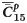
Average outflow facility C¯15p, as a function of intraocular pressure and for a range of values of α.The average outflow facility
C¯15p
is calculated using Eq (28). Note: the average outflow facility curves shown in the figure above are not the same as the average outflow facility curves shown in Fig 2, as the pressure range over which averaging occurs are different in the two figures. For example for α equal to 0.05, at 20 mm Hg the average outflow facility in the above figure is just over 0.4 microlitres/minute/mm Hg, while in Fig 2 it is about just under 0.6 microlitres/minute/mm Hg. The relative difference in the two average outflow facilities increases with increasing α.